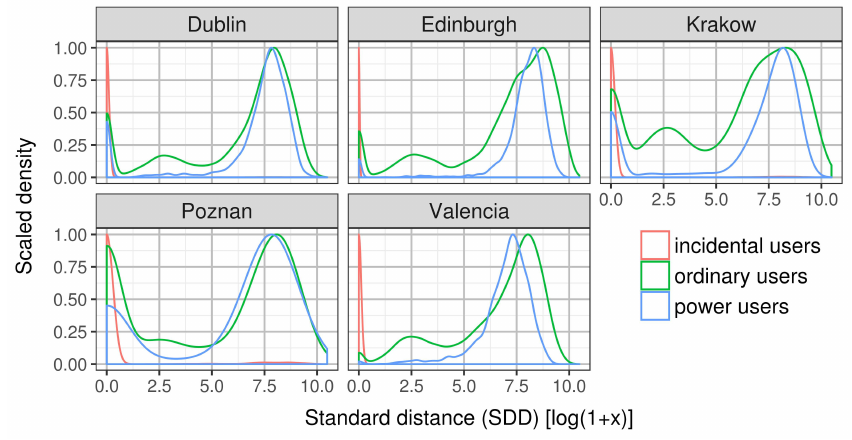
Figure 5. Comparison between posting activity classes in respect to the standard distance value. Table 3. Contingency table between mobility (Stationary, Traveling) and posting activity (Incidental, Ordinary, Power) user types. Row conditional relative frequency is included in parentheses.